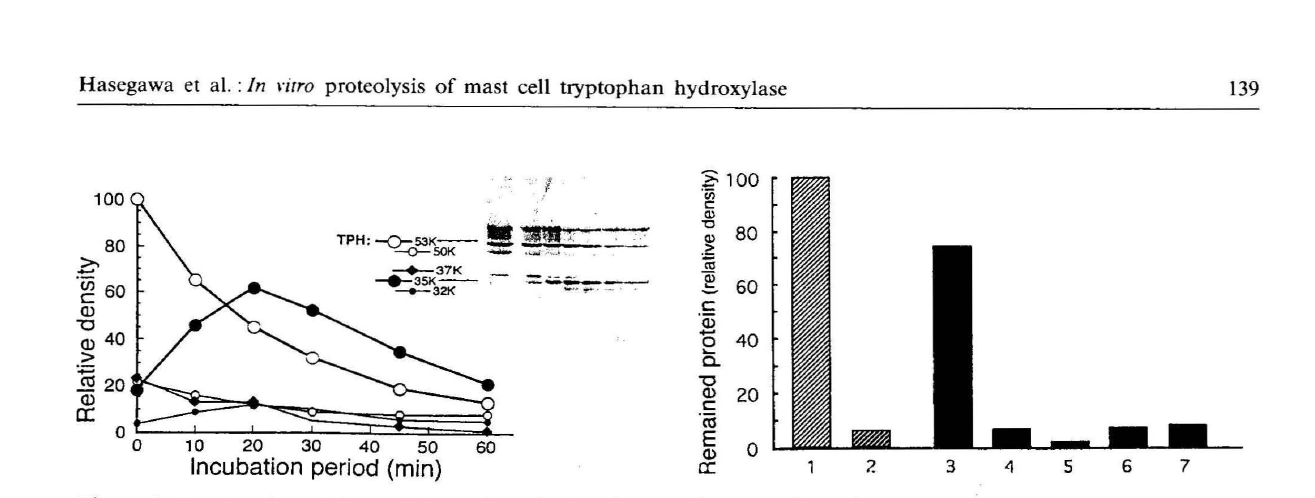
Figure 2, Effect of protease inhibitors on in vitro degradation of tryptophan hydroxylase protein: Cell extracts of both P-815 (6 mglml) and RBL2H3 (10 mglml) were prepared separately with PBS(-). Then, 3 mglml of each protein were mixed in saline containing the indicated inhibitors, and in cubated at 30°C for 30 min. The mixture was subjected to the Western blot analysis as described in the legend to Figure 1. TPH: tryptophan hydroxylase (Mr= 53,(00). Lanes are: I) P-815 alone, 2) RBL2H3 alone, 3-7) mixed extracts and in hibitors; 3) I mM PMSF, 4) 20llg/ml, 5) 100 Ilglml of leu peptin, 6) 20 Ilglml of pepstatin, and 7) 10 mM EDT